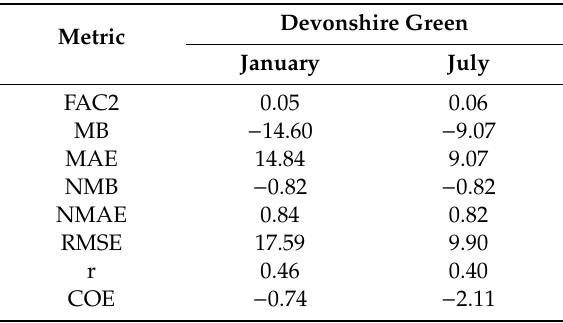
Table 9. The value of various statistical metrics used for assessing the performance of the model for predicting PM 10 concentrations in the month of January and July 2017 at Devonshire Green monitoring